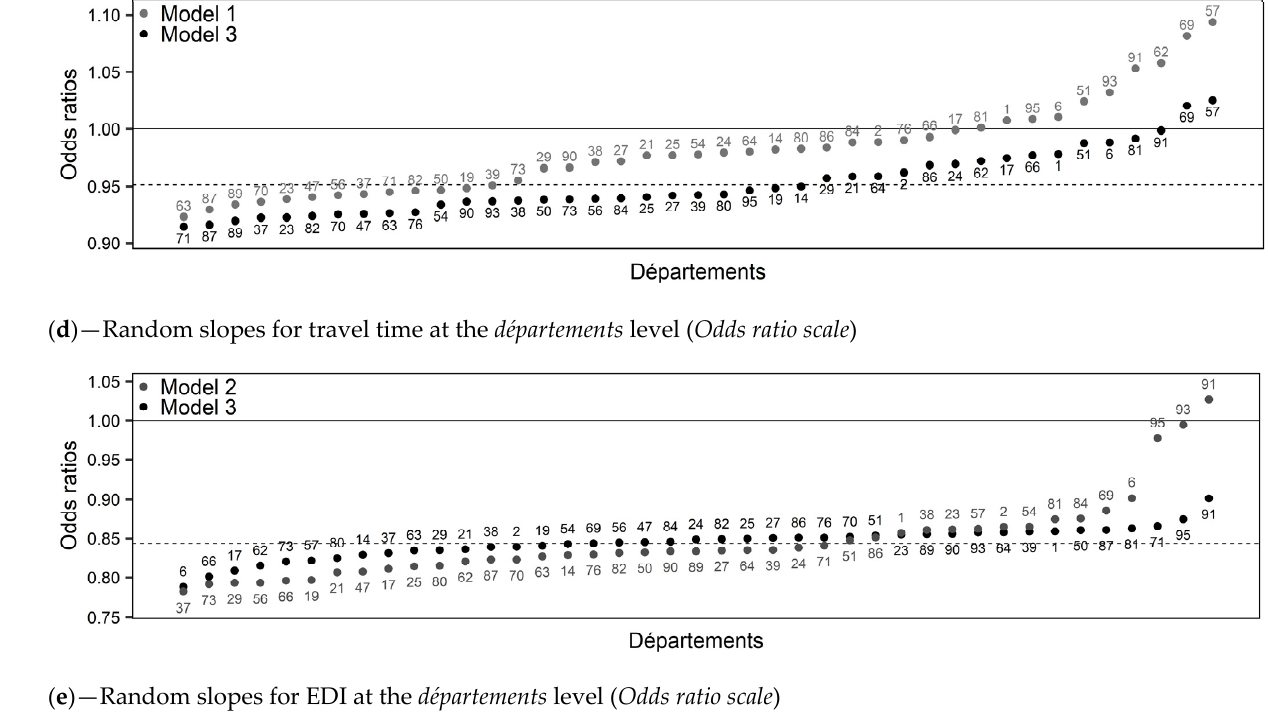
Figure 2. Illustrations of the random effects. ( a ) Random intercepts at the IRIS level ( probability scale ), ( b ) Random intercepts at the départements level ( probability scale ), ( c ) Random slopes for age at the départements level ( Odds ratio scale ), ( d ) Random slopes for travel time at the départements level ( Odds ratio scale ), ( e ) Random slopes for EDI at the départements level ( Odds ratio scale ).